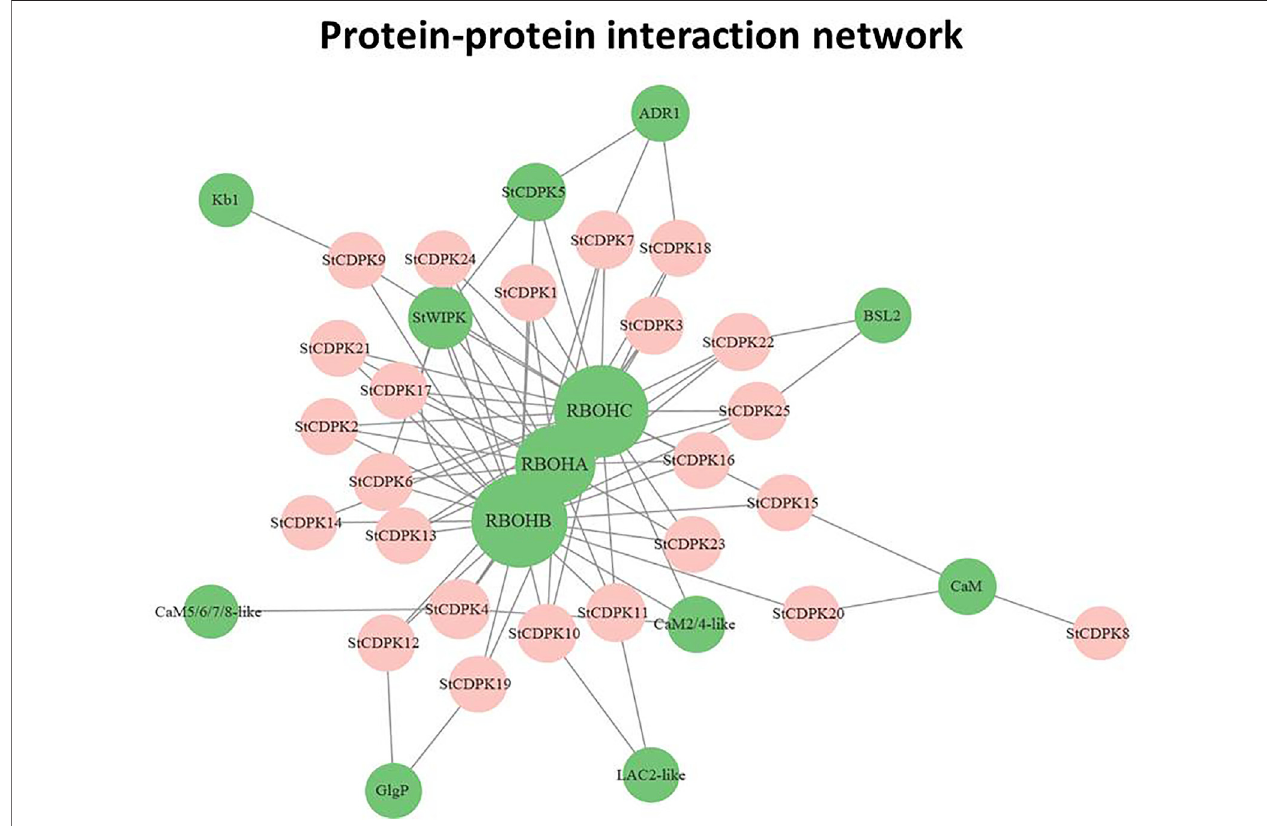
FIGURE6| Protein-protein interaction networkof StCDPK s. Acomplexnetwork ofallpotatoCDPKs and proteins identi fi ed and greenlabeled circles contains the interacting